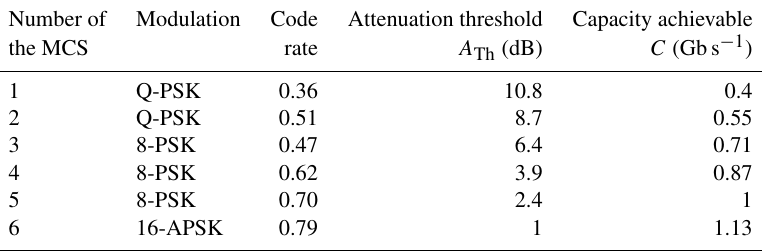
Table 3. Extract of possible modulation and coding schemes (MCSs) as defined in the Digital Video Broadcasting – Satellite second- generation (DVB-S2X) standard (DVB, 2014) and of their operating